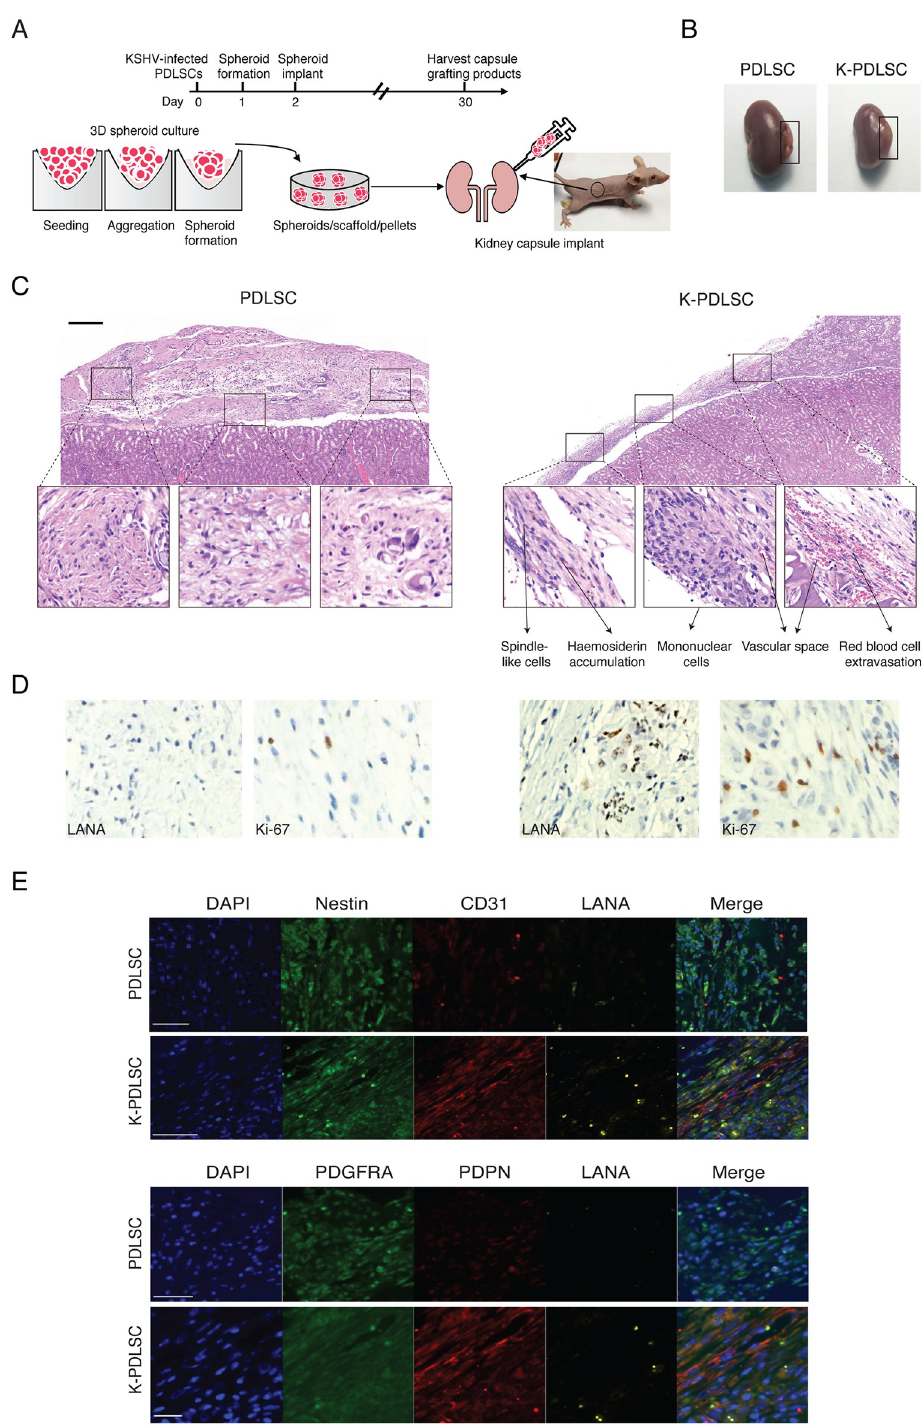
Fig 7. Ectopic transplantation of PDLSC and K-PDLSC spheroids in mice under the kidney capsule. (A) Schematic diagram illustrating the process of transplanting PDLSC and K-PDLSC spheroids under the renal capsule of nude mice. ( B) The kidneys transplanted with PDLSC and K-PDLSC spheroids were harvested after 28 days. ( n = 3–4 mice for each group). ( C) Representative images of H&E staining of PDLSC and K-PDLSC spheroids transplants. Scale bar, 200 μ m. (D) IHC staining of PDLSC and K-PDLSC spheroids transplants for LANA and Ki-67. (E) Immunofluorescent overview of Nestin, CD31, PDGFRA, PDPN, and LANA expression in PDLSC and K-PDLSC spheroids under the renal capsule. Scale bar, 50 μ